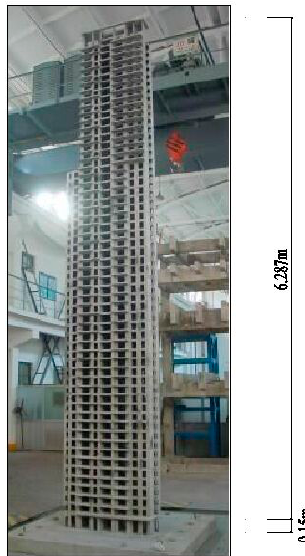
Figure 7. Picture of the model.